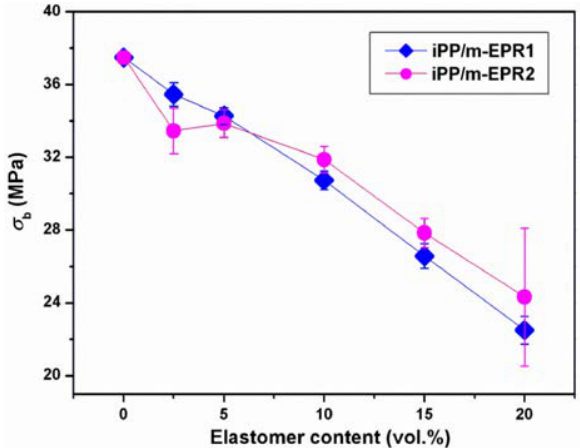
Figure 5. Tensile strength at break of the iPP/m-EPR blends in de- pendence on volume content of added elastomers The elongation at break, ε b , usually behaves inversely to the tensile strength at break, σ b . Indeed, the ε b values increases with increased m-EPR1 and m-EPR2 content al- most linearly after 2.5 vol.% of elastomer (Figure 6). How- ever, in distinct to σ b values behavior, ε b values of both blend systems are very close in whole concentration range.